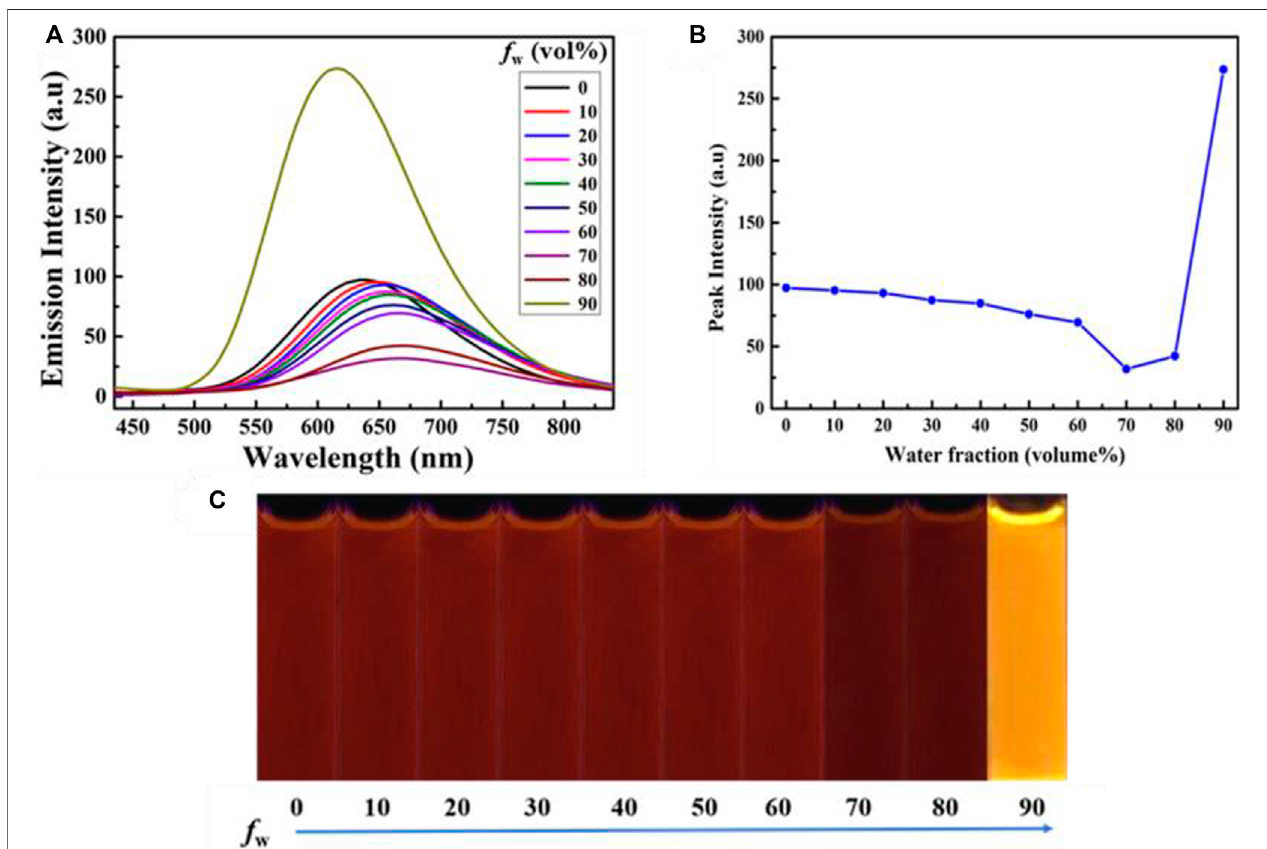
FIGURE 1 | (A) Emissive spectra of the dilute solutions of compound 1 (concentration: 2.0 × 10 − 5 mol L − 1 ) in CH 3 CN-H 2 O mixtures with varying f w values. (B) Changes in the emission intensity of 1 at 618 nm in CH 3 CN-H 2 O mixtures with varying f w values (0 – 90%). (C) PL images of 1 (20 μ M) in CH 3 CN-H 2 O mixtures with varying f w values (0 – 90%) under 365 nm UV light.